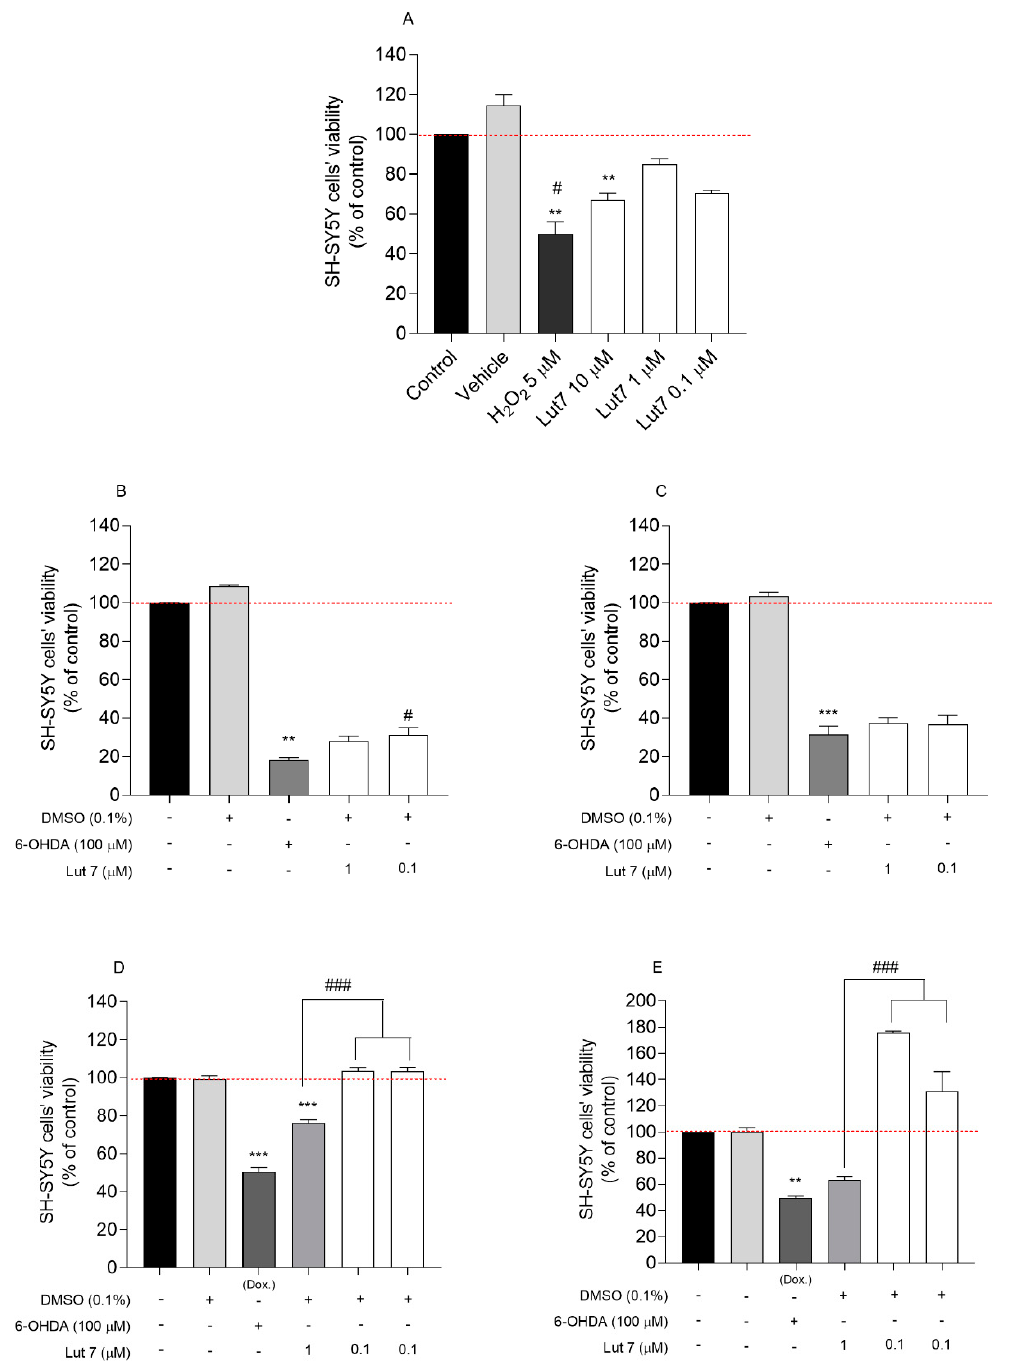
Figure 1. Cytotoxicity induced by Luteolin-7-O-glucoside (Lut7) in SH-SY5Y cells after 24 h of treatment ( A ); Neuroprotective effects of Lut7 against 6-OHDA induced neurotoxicity on undifferentiated SH-SY5Y cells: 24 h incubation ( B ); 48 h incubation ( C ). Neuroprotective effects of Lut7 against 6-OHDA induced neurotoxicity on RA-differentiated SH-SY5Y cells: 24 h incubation ( D ); 48 h incubation ( E ). The values in each column represent the mean ± SEM of at least three independent experiments carried out in triplicate. Statistical calculations were performed with ANOVA via the Tukey post hoc test and significant differences were considered for *** p < 0.001; ** p < 0.01 (vs. control); ### p < 0.001 and # p < 0.05 (vs. 6-OHDA). Doxorubicin was used as positive control; DMSO 0.1% was used as vehicle. Negative control (untreated cells) was considered to be 100% viable.